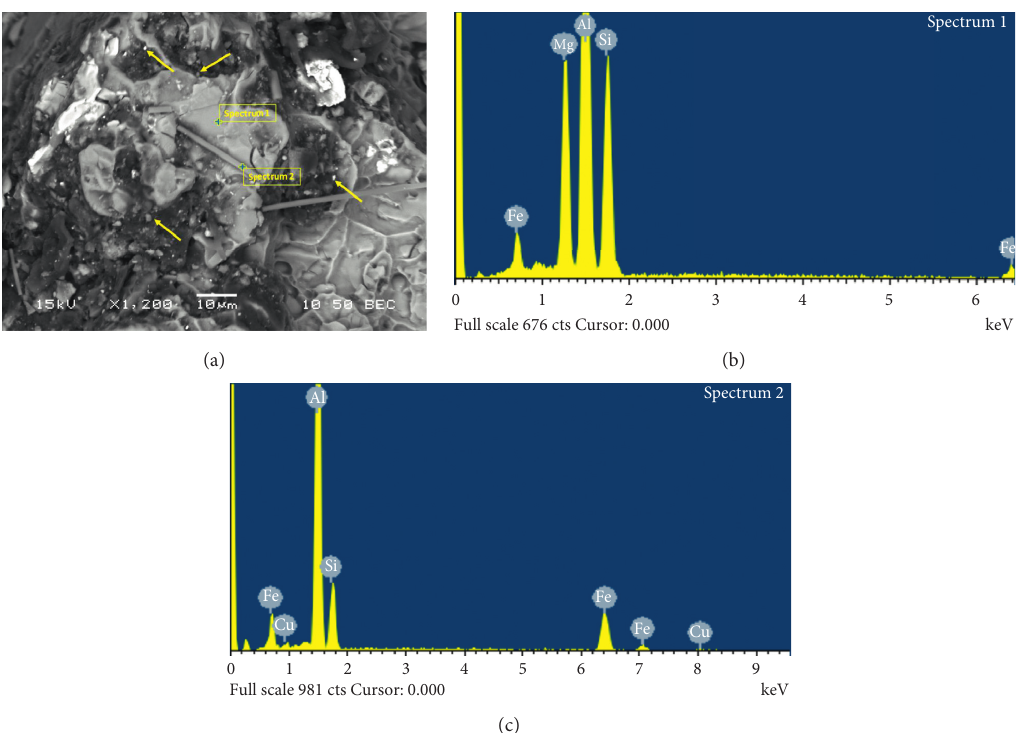
Figure 3: (a) BSE image of T6-treated M1S alloy after stabilization at 250 ° C for 1 hour showing Fe-bearing phases and (b), (c) EDS spectra corresponding to the points of interest in (a), confirming the presence of π -Al-Si-Mg-Fe, and β -Al-Si-Fe phases, respectively.